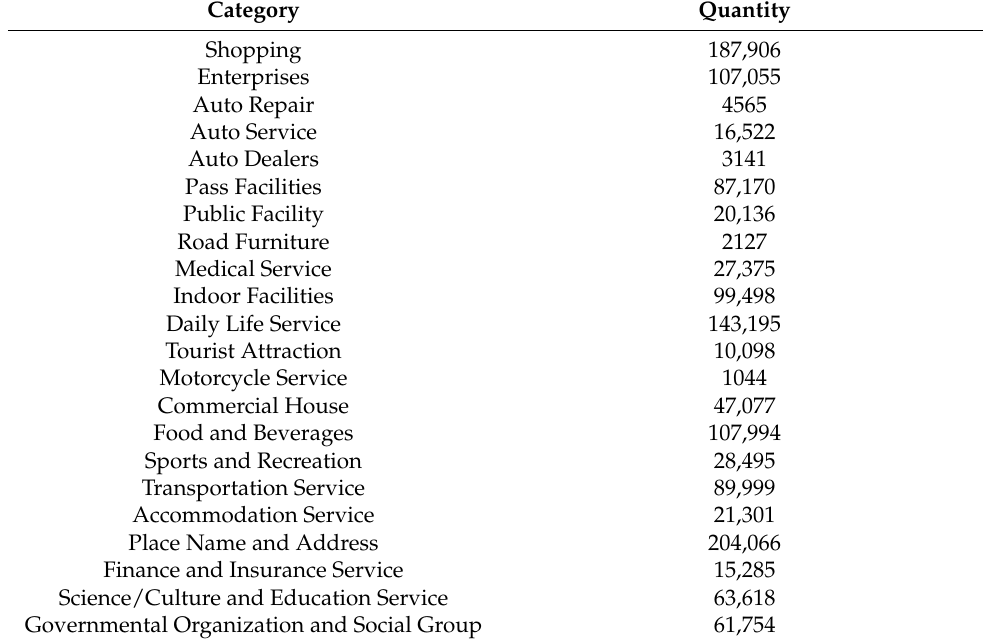
Table 2. Category and quantity of POI